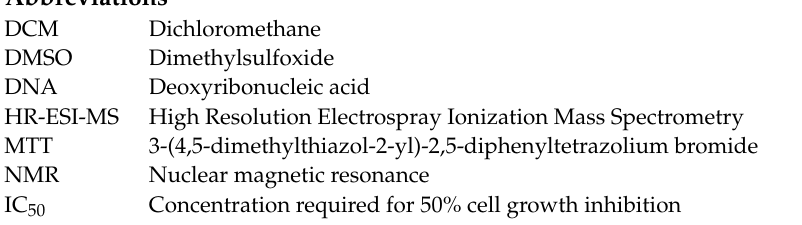
Figure S13: Dose-response curves for 1 – 6 , 8 – 10 and cisplatin in the OVCAR-3 cell line. Figure S14: Dose-response linear regression of optical density versus concentration, in ovarian tumor cells subjected to treatment for 24 h. Table S1: Cell growth inhibitory capacity of formamidinate ligands ( 1 , 2 ), dirhodium(II,II) complexes ( 3 – 10 ) and cisplatin in cancer cell